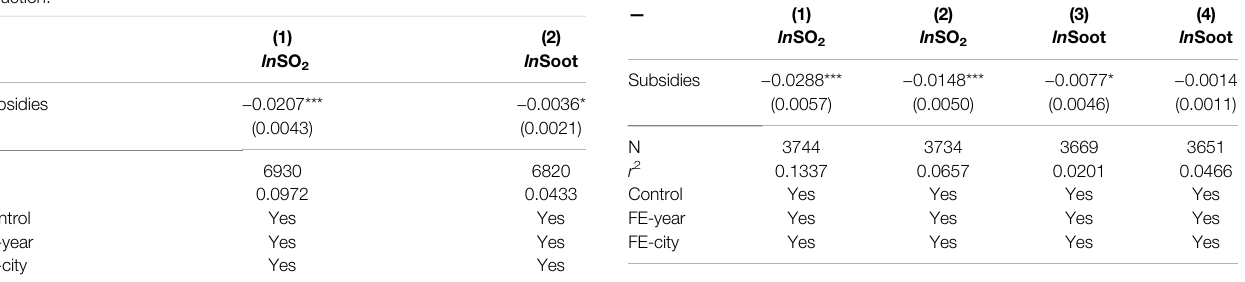
TABLE 4 | Government subsidies ’ effects on thermal power plants ’ emission reduction.